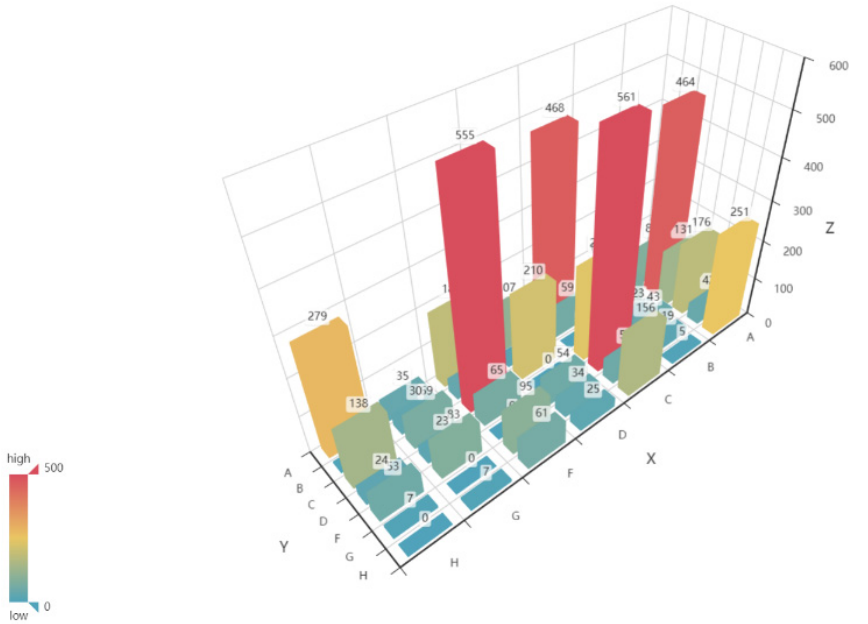
Figure 7. The number of transitions between morphologic bar types. The X coordinate represents the initial type, Y represents the following type, (x, y) represents the transition from type x to type y, and Z represents the number of type transitions.